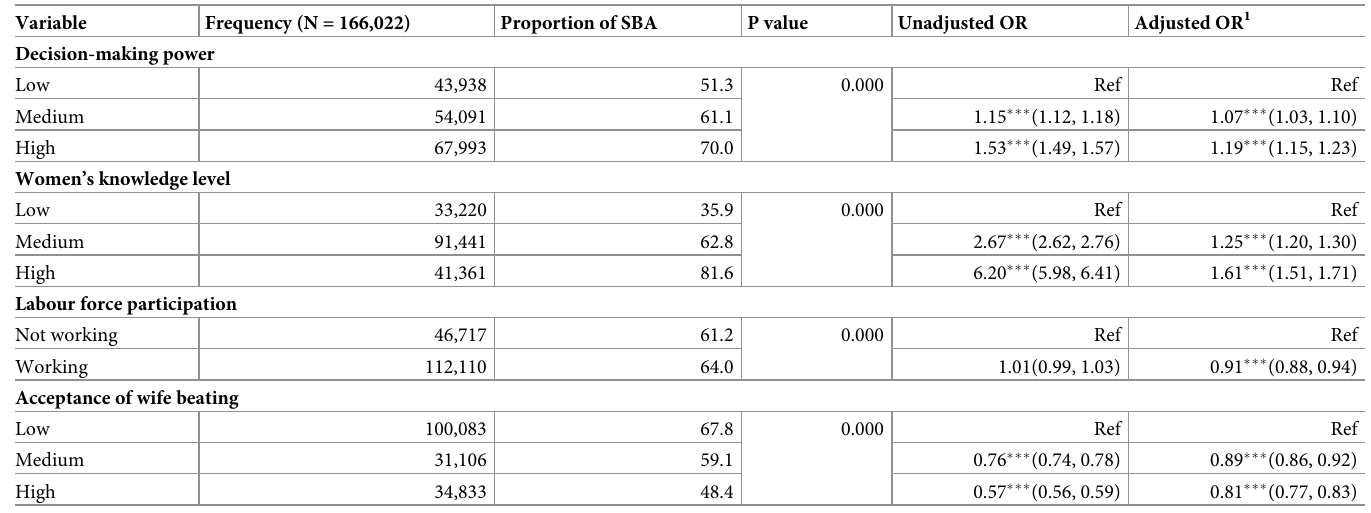
Table 3. Predictors of skilled birth attendance utilization among women in sub-Saharan